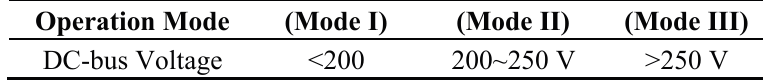
Table 3. DC-link voltage range definition for each operation mode.